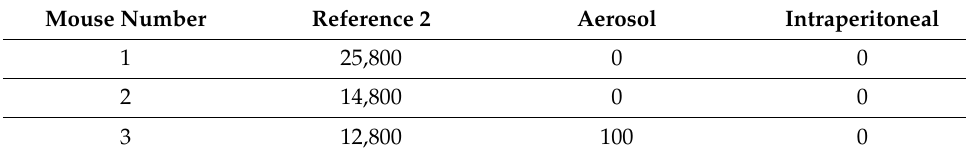
Table 5. The data of bacteriological examination (CFU/mL) of the animals.